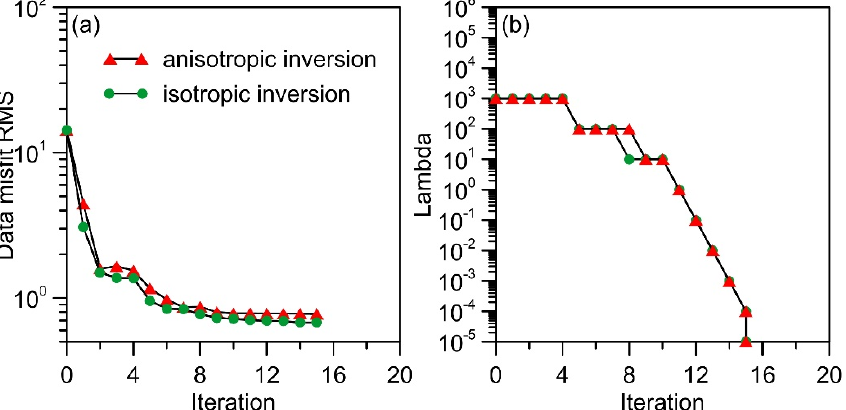
Figure 6. Plots of inversion parameters for the inversion of synthetic example 1. ( a ) Data misfit RMS; ( b ) regularization parameter λ .